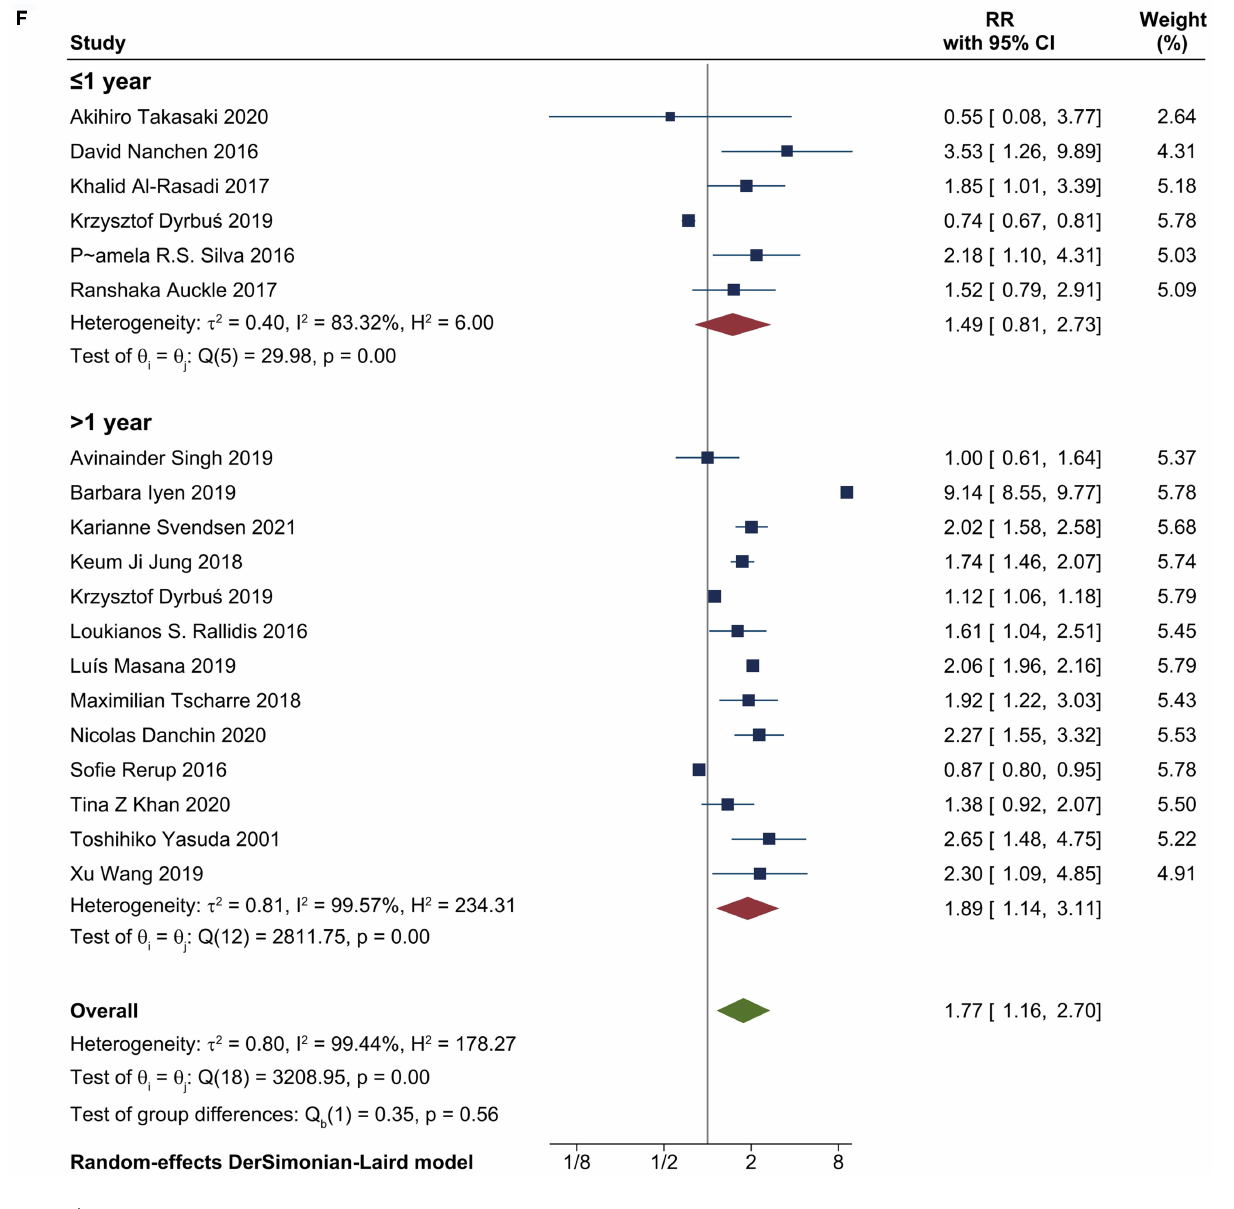
(95% CI 1.55–2.35), all cause of death 1.03 (95% CI 0.80–1.32), We conducted subgroup analysis for different cohorts. The RR for general population, hyperlipidemia, CHD, ACS and